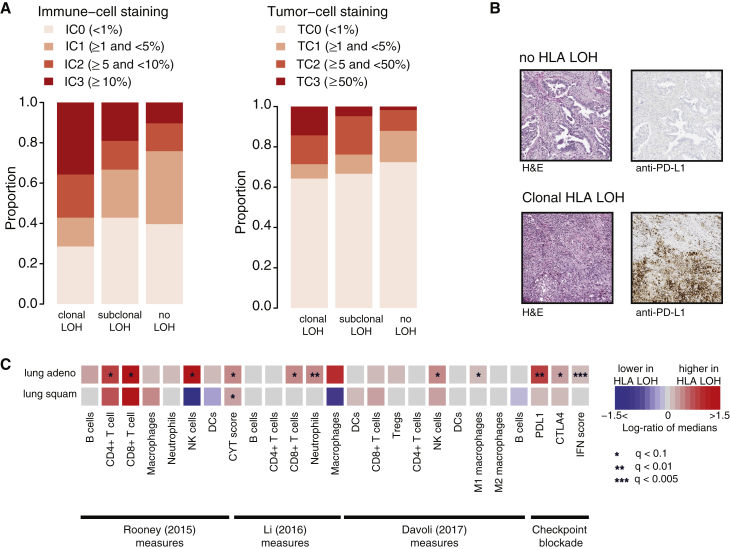
HLA LOH and Immune Phenotypes(A) Anti-PD-L1 staining on FFPE diagnostic blocks from tumors with clonal HLA LOH, subclonal HLA LOH, and no observed HLA LOH. Immune-cell-based staining and tumor-cell staining is depicted.(B) Staining from two representative tumors, one without HLA LOH and one with clonal HLA LOH is shown.(C) The log-ratio of medians between tumors containing an HLA LOH event at all loci and those without any HLA LOH event is shown for published immune microenvironment measures and signatures. Increase of an immune measure among tumors with HLA LOH is shown in red, and a decrease is shown in blue. False discovery rate (FDR) (q) values comparing the distribution of immune measures between the HLA LOH groups are indicated by asterisks (∗).See also Figure S5 and Table S1.